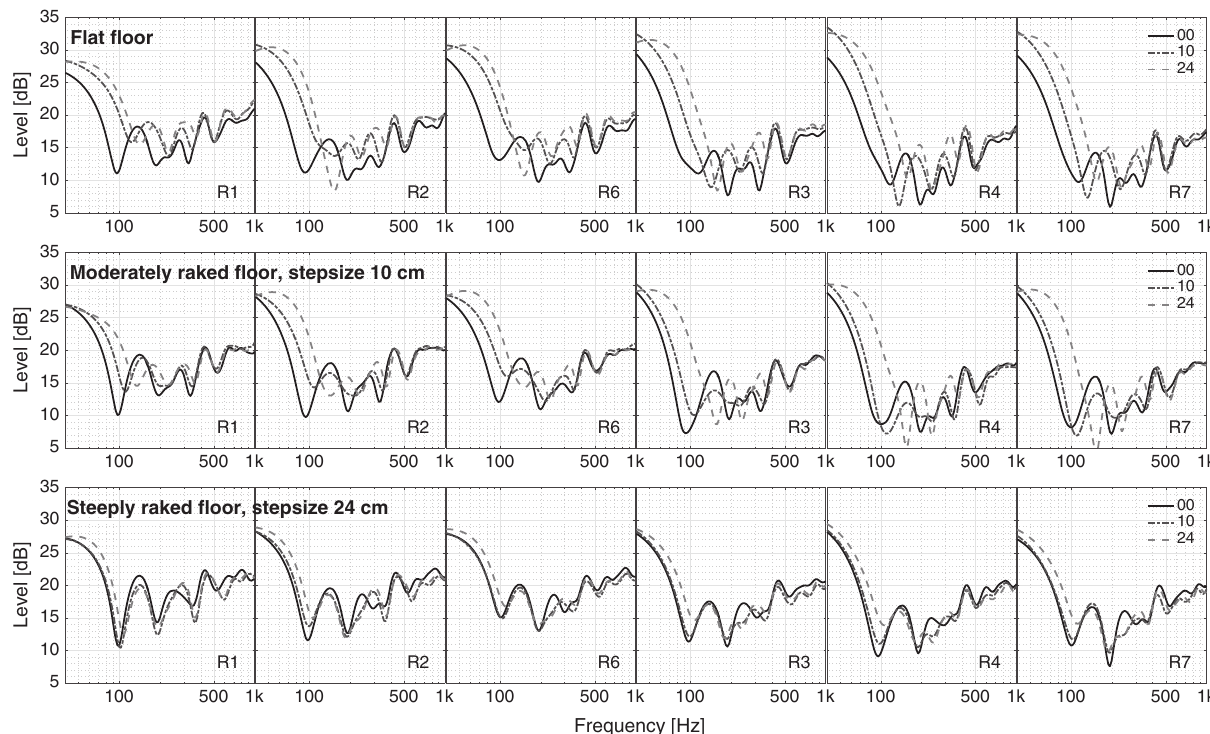
Figure 4. The 1/3-octave smoothed magnitude responses at 15 ms after the direct sound after calibration at 10 m and compensation for spherical divergence. The responses show the effect of the seat type across fl oor raking (closed = 00, 10-cm opening = 10, and 24- cm opening =